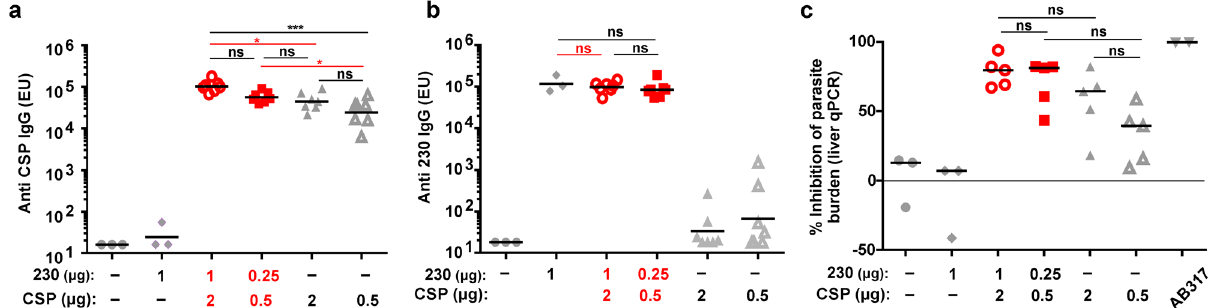
Fig. 7 Immunization with CPQ/CSP/230 protects mice from sporozoite challenge. C57BL/6 mice received 3 intramuscular immunizations on day 0, 14 and 28. On day 40 ( a ) anti-CSP and ( b ) anti-230 IgG EU was measured prior to challenge. c Mice were challenged intravenously with 2,000 PbPfCSP sporozoites and % inhibition in parasite liver burden was determined by using qPCR to assess parasite 18S rRNA relative to mouse GAPDH mRNA, compared to non-immunized mice. This experiment was performed with n = 5 mice for the CSP/230 high and low dose group, as well as the CSP high and low dose group; and n = 3 of mice for the 230 group and CPQ alone group. For a , b the line represents geometric mean, and one-way ANOVA followed by Tukey test using log-transformed data was used to analyze differences, *** p < 0.0005, * p < 0.05. Only p values among mice immunized with homologous antigens are shown. For c , the line represents median, and a Kruskal-Wallis test was used to analyze differences. Red symbols or outlines indicate bivalent, liposome-displayed CSP/230.